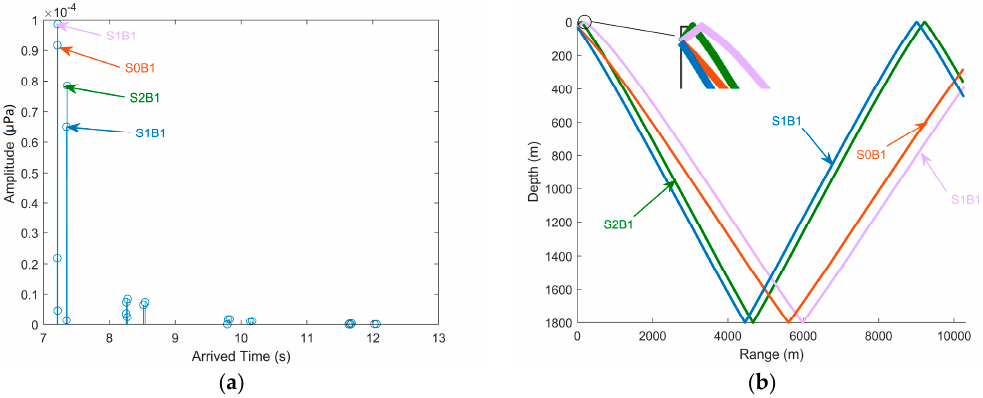
Figure 21. ( a ) Arrival structure of the eigen-rays (10.3 km). ( b ) Ray trace in the shadow zone (10.3 km).